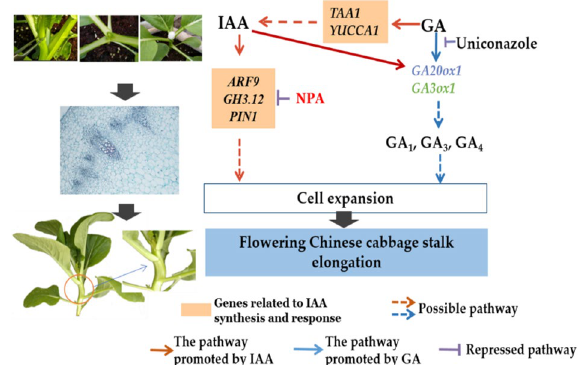
Figure 5. A hypothetical model of IAA and GA-stimulated stalk elongation in flowering Chinese